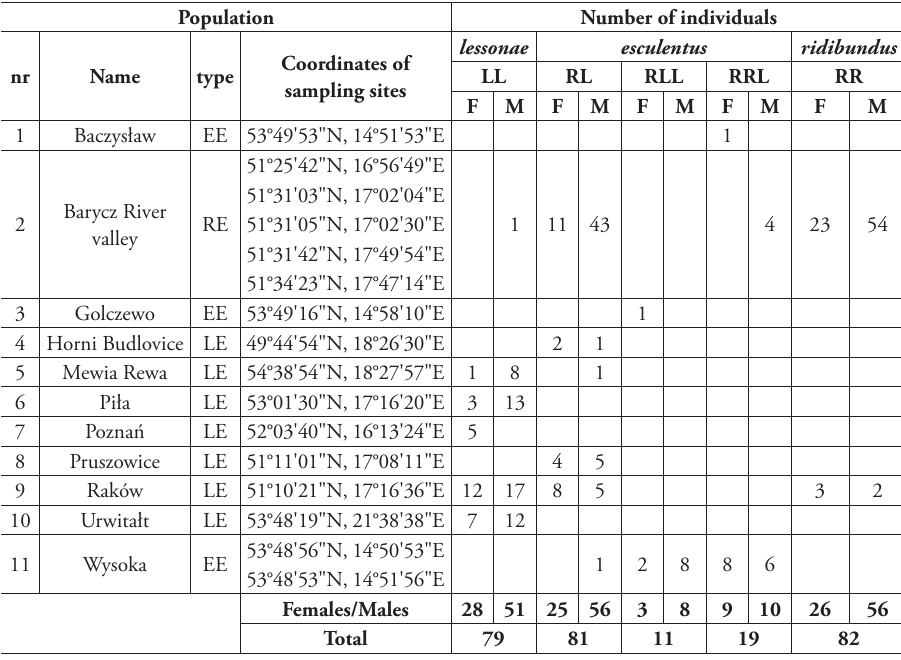
Table 1. Number, collection site, sex, taxonomic status and genotype of adult individuals. Population Number of individuals lessonae esculentus ridibundus Coordinates of nr Name type sampling sites